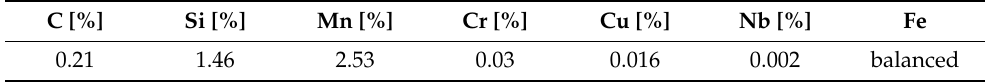
Table 1. Chemical composition of the DP1200HD steel and main alloying elements.